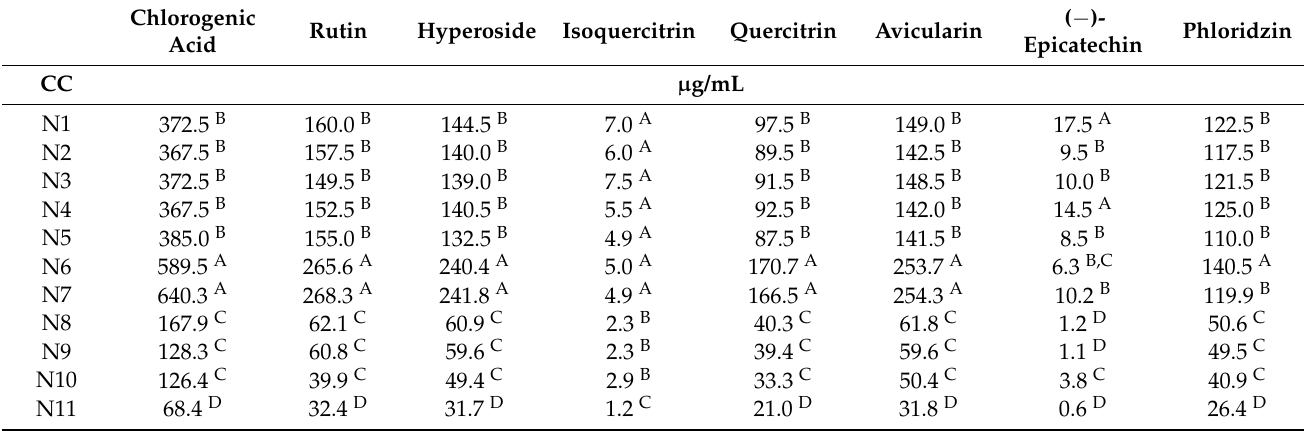
Figure 4. Results of the capsule disintegration test. The means followed by different letters are significantly different at p < 0.05. Table 2. Results of the in vitro dissolution test after 30 min. The means followed by different letters in the columns are significantly different at p <